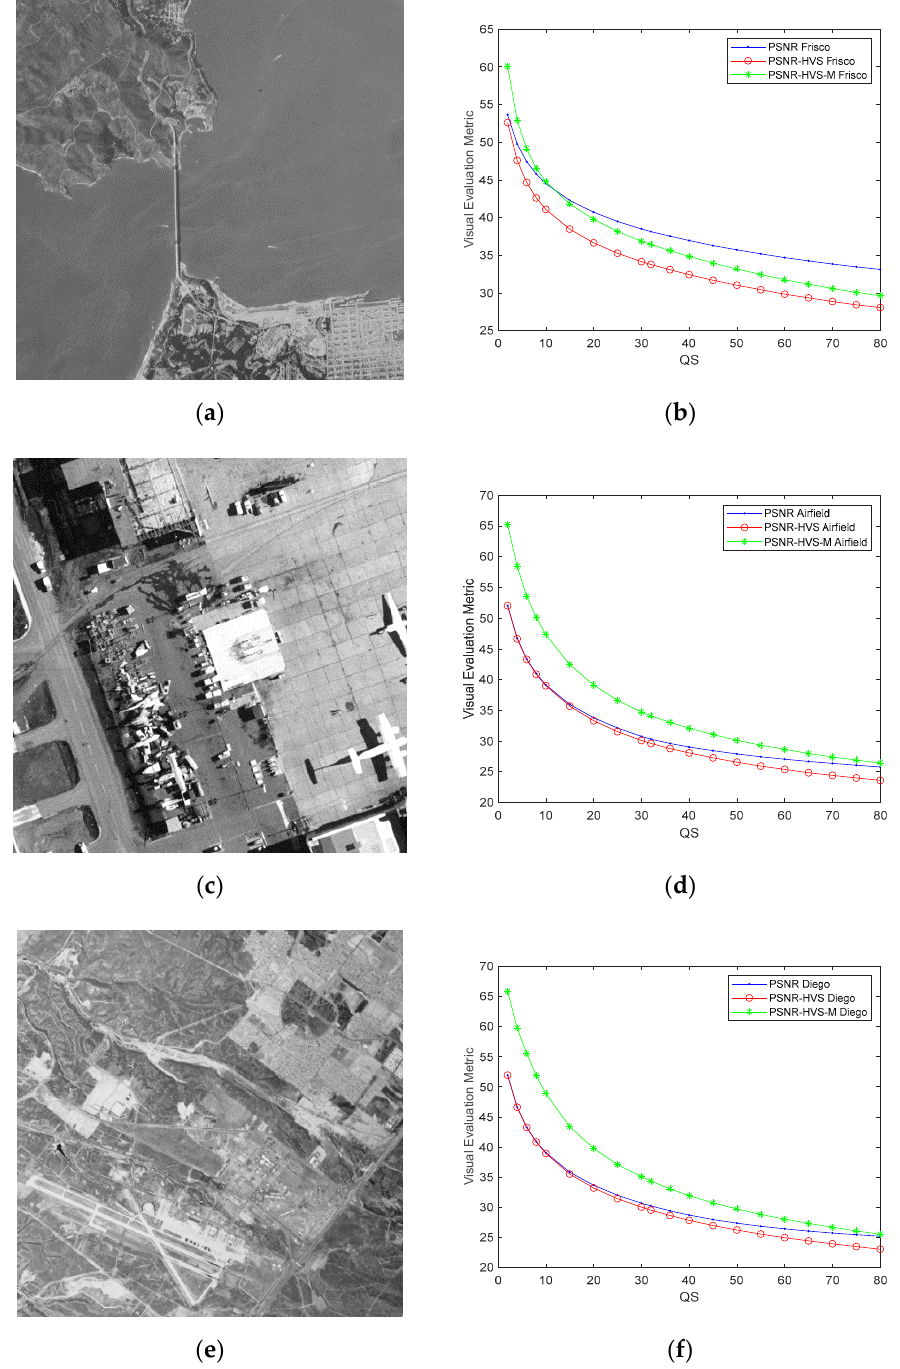
Figure 1. Test grayscale images Frisco ( a ), Airfield ( c ), and Diego ( e ), all of size 512 × 512 pixels, and dependences of the considered metrics (PSNR, PSNR-HVS, PSNR-HVS-M, all in dB) on the quantization step (QS) for the coder AGU for these test images (( b ), ( d ), and ( f ),